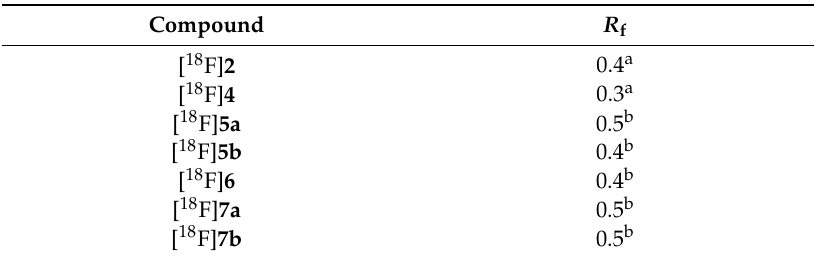
Table 2. R f values of reference compounds.